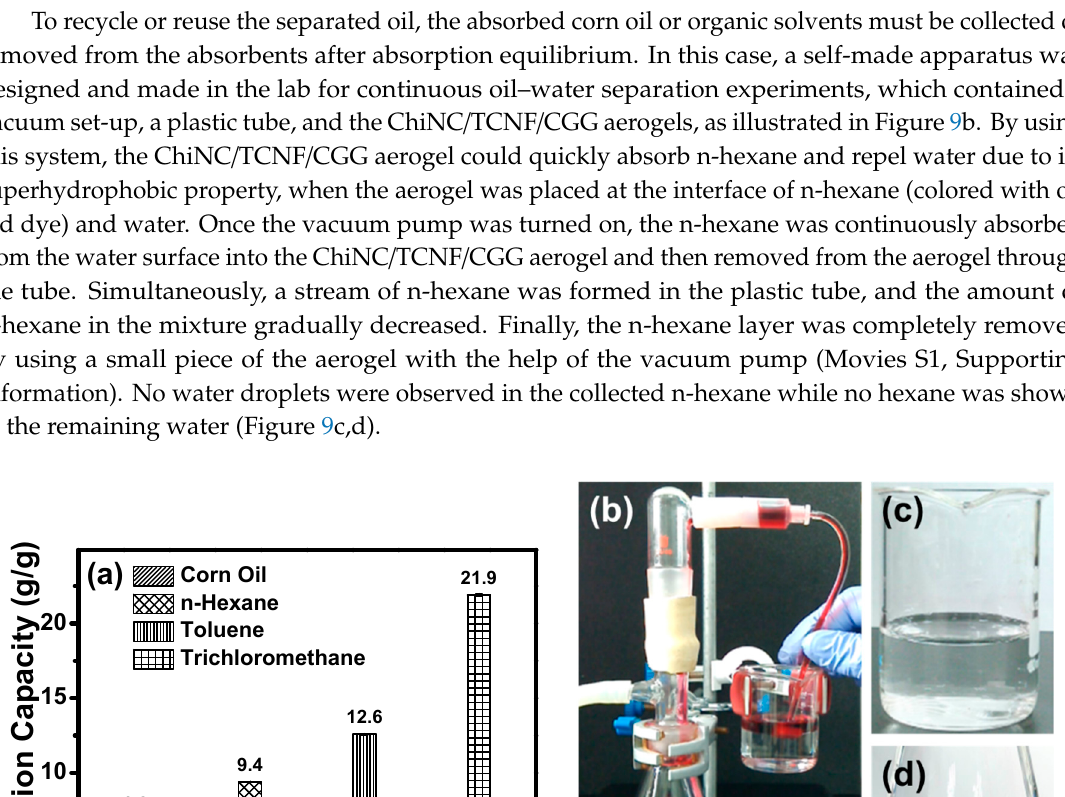
Figure 8. The absorption behavior of modified aerogels ( a ) from the surface of water, ( b ) from beneath the surface of water. Corn oil in ( a ) and trichloromethane in ( b ) were dyed with red oil dye for clarity.